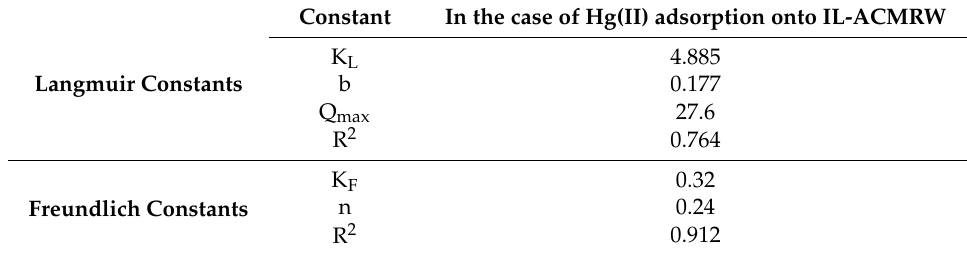
Table 2. Langmuir and Freundlich constants of Hg(II) ions on IL-ACMRW (ionic liquid modified activated carbon from mixed recyclable waste).